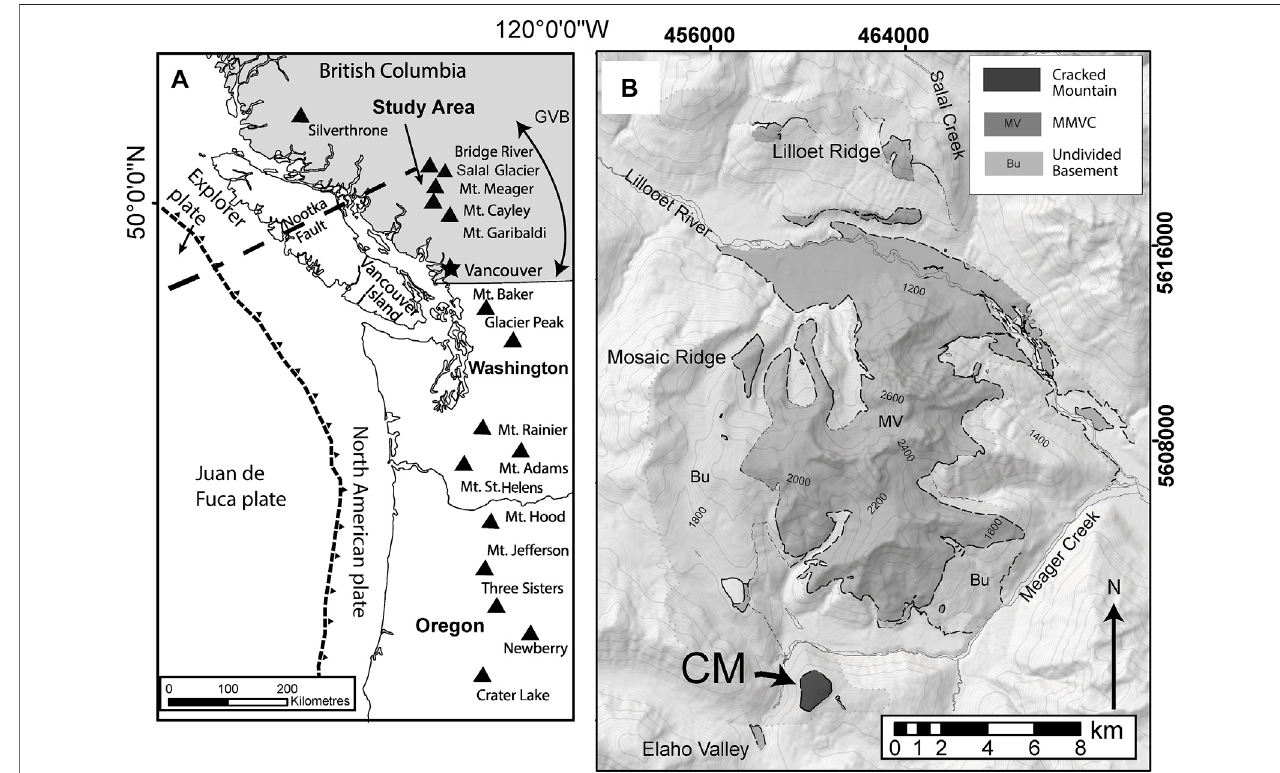
FIGURE 1 | Geologic setting of Cracked Mountain volcano. (A) Map of the Cascade volcanic arc in the USA and Canada [i.e., Garibaldi volcanic belt (GVB)] (modi fi ed from Wilson and Russell, 2017; Harris et al., 2022). (B) Undivided geological map of Mount Meager volcanic complex showing the distribution of volcanic deposits (MV), basement (Bu) (Woodsworth, 1977; Read, 1979; Harris and Russell, 2021). Cracked Mountain (CM) is situated south of the main MMVC (Wilson and Russell, 2018; Harris and Russell, 2021). The map uses Universal Transverse Mercator Projection (UTM) zone 10U North American Datum 1983.